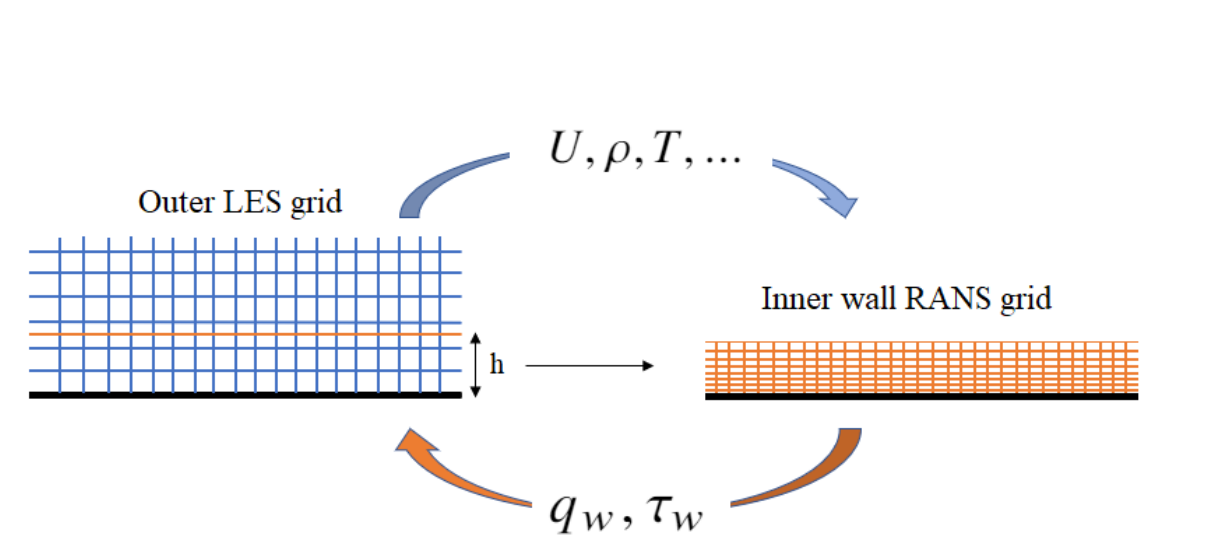
Figure 1. Schematic of the mesh setup for wall-modeled large-eddy